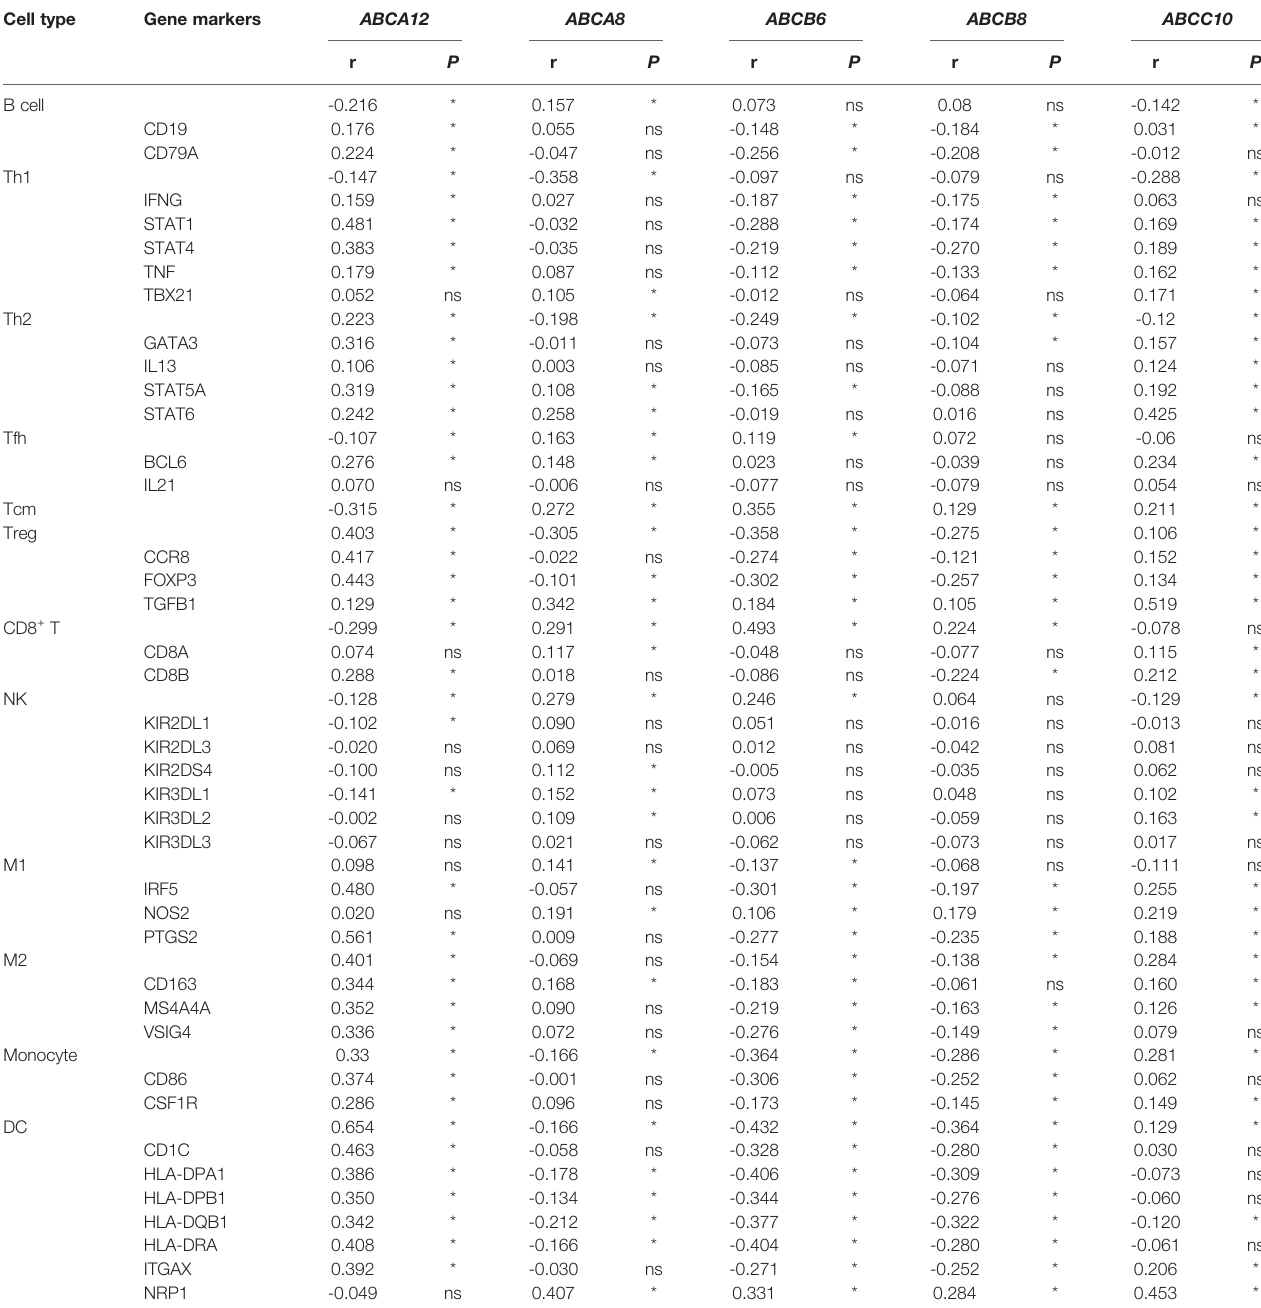
TABLE 4 | Correlations of the expression of the fi ve hallmark ABC transporters with the abundance of gene markers of immune cell in fi ltration in TC. Cell type Gene